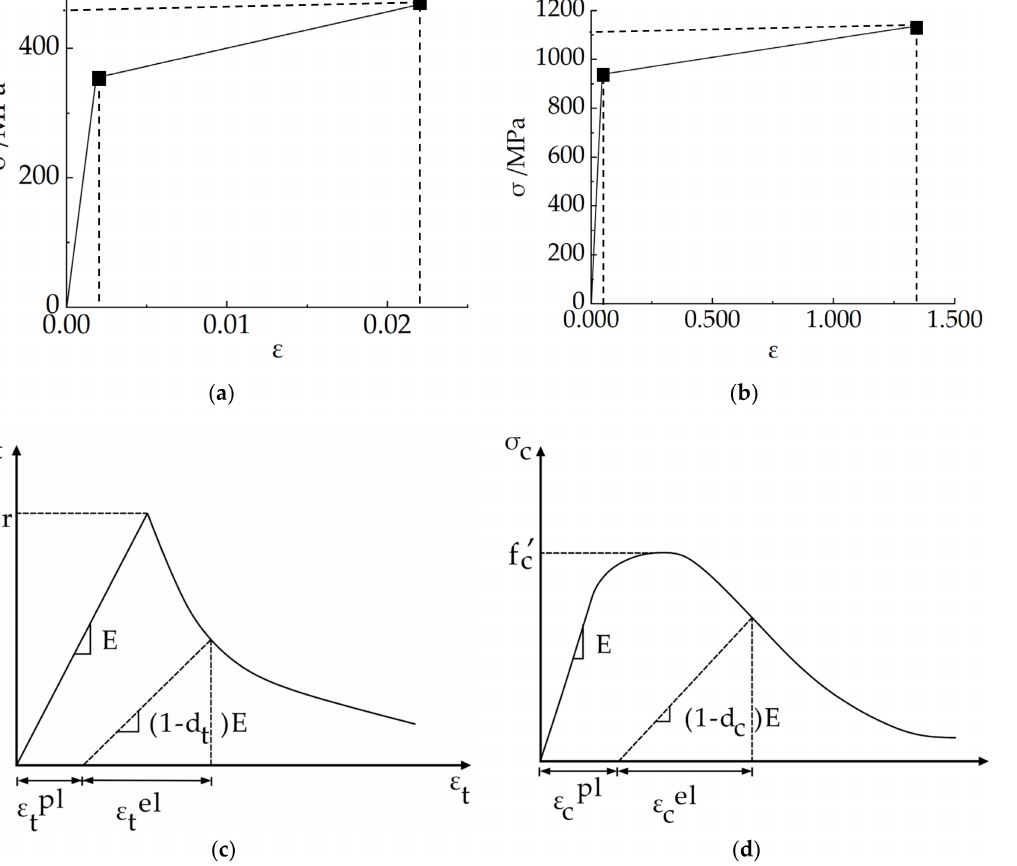
Figure 17. Constitutive model of materials in the FEM: ( a ) Q355B steel; ( b ) 10.9M20 high–strength bolt; ( c ) Stress–strain relationship of the concrete in tension; ( d ) Stress–strain relationship of the concrete in